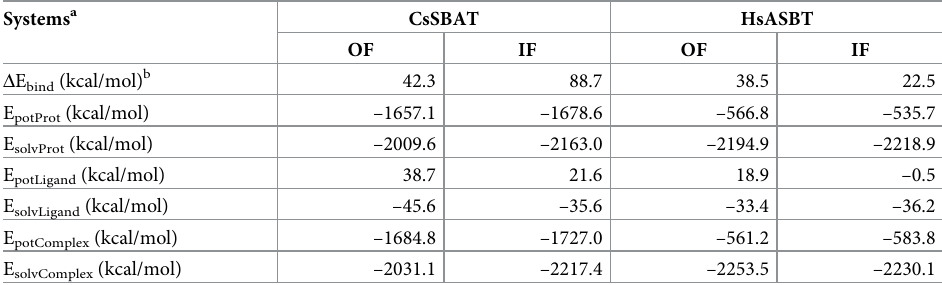
a In all systems, 12–50 ns simulation was used for calculation of MM/PBSA except for OF-CsSBAT for 24–50 ns. b More positive Δ E bind values indicate better binding. All abbreviations are defined in “Molecular dynamics (MD) simulation and binding free energies” section